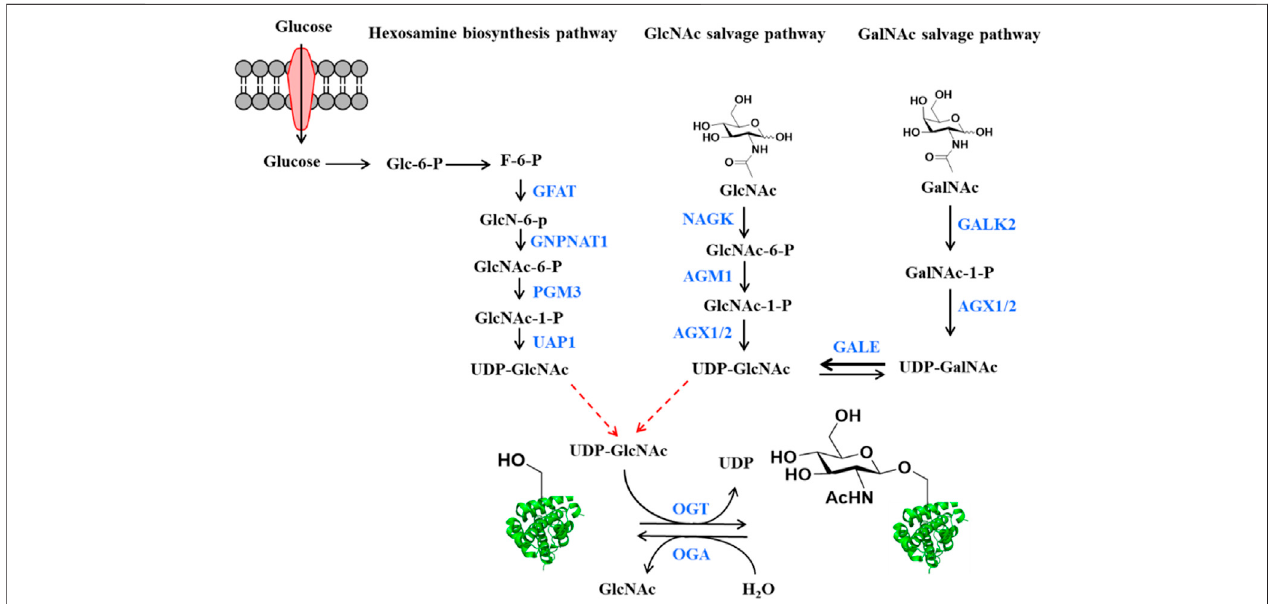
FIGURE 1 | The source of O-GlcNAcylation donor UDP-GlcNAc in the cells. Glucose is converted to UDP-GlcNAc through the hexosamine biosynthetic pathway (HBP). Enzyme names shown in blue. GFAT: Glutamine fructose-6-phosphate amino-transferase, GNPNAT1: Glucosamine-Phosphate N-Acetyltransferase 1, PGM3: Phosphoglucomutase 3, UAP1: UDP-N-Acetylglucosamine pyrophosphorylase 1. UDP-GlcNAc also can be produced by the GlcNAc and GalNAc salvage pathways. Enzyme names shown in blue. NAGK: GlcNAc kinase, AGM1: GlcNAc-6-phosphate mutase, AGX1 or AGX2: UDP-GlcNAc pyrophosphorylase, GALK2: Galactokinase 2, GALE: UDP-galactose-4 ′ -epimerase. Bold arrow represents that reaction is easier to perform. O-GlcNAc transferase (OGT) and O-GlcNAc hydrolase (OGA) regulate the addition and the removal of O-GlcNAc, respectively.